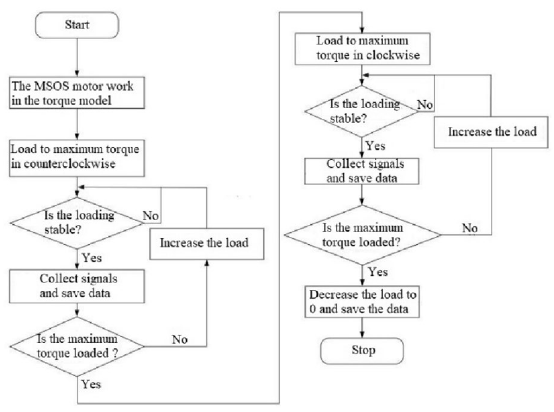
Figure 8. Flow chart of the calibration of angle measurement